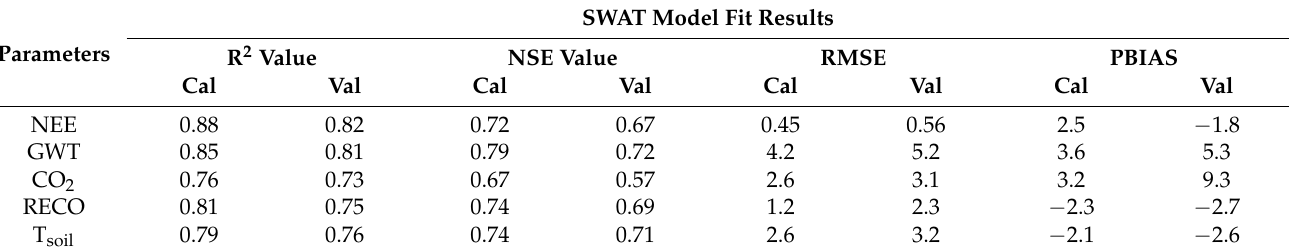
Figure 11. Spatiotemporal CO 2 Emissions (µmol CO 2 – C m – 2 day – 1 ).